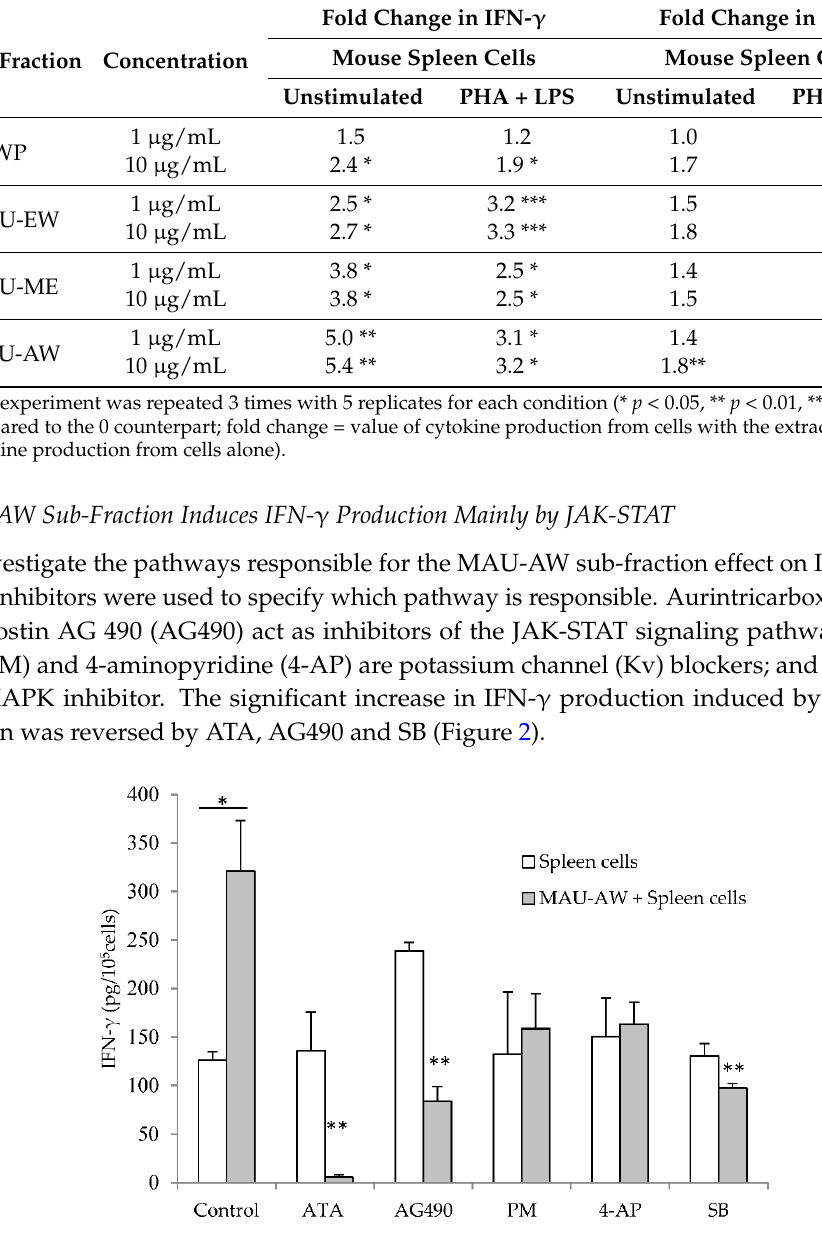
Figure 2. MAU-AW induces IFN- γ production mainly through the JAK-STAT pathway. MAU-AW increased IFN- γ production from mouse spleen cells (* p < 0.05). Adding ATA (50 µ M), AG490 (50 µ M) and SB (10 µ M), but not PM (5 µ M) nor 4-AP (5 mM), to the spleen cell culture for one hour prior to the addition of MAU-AW (10 µ g/mL) reversed MAU-AW effect on IFN- γ production (** p < 0.01). Data represent the average of the cytokine level from two independent experiments ( ˘ SEM), and each experiment consists of a minimum of four replicates per